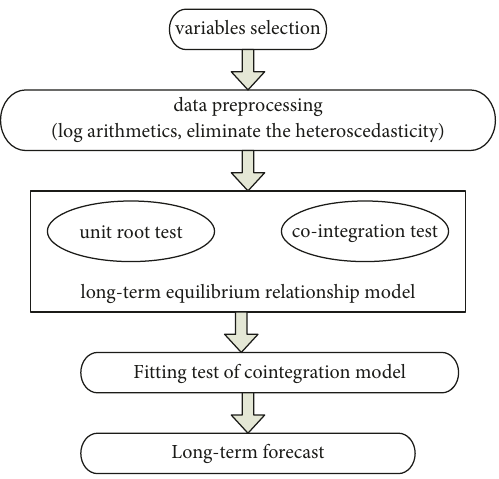
Figure 1: Modelling framework of CO 2 emissions for energy consumption.